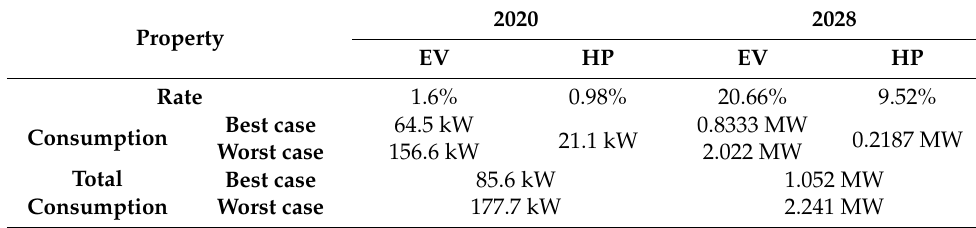
Table 6. Distribution cable loading for 2020 and 2028.